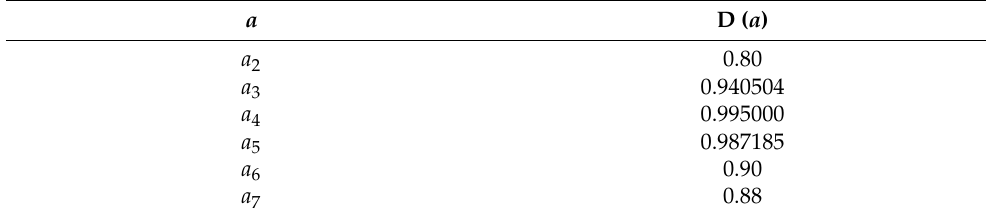
Table 9. New state distributions of Figure 5.